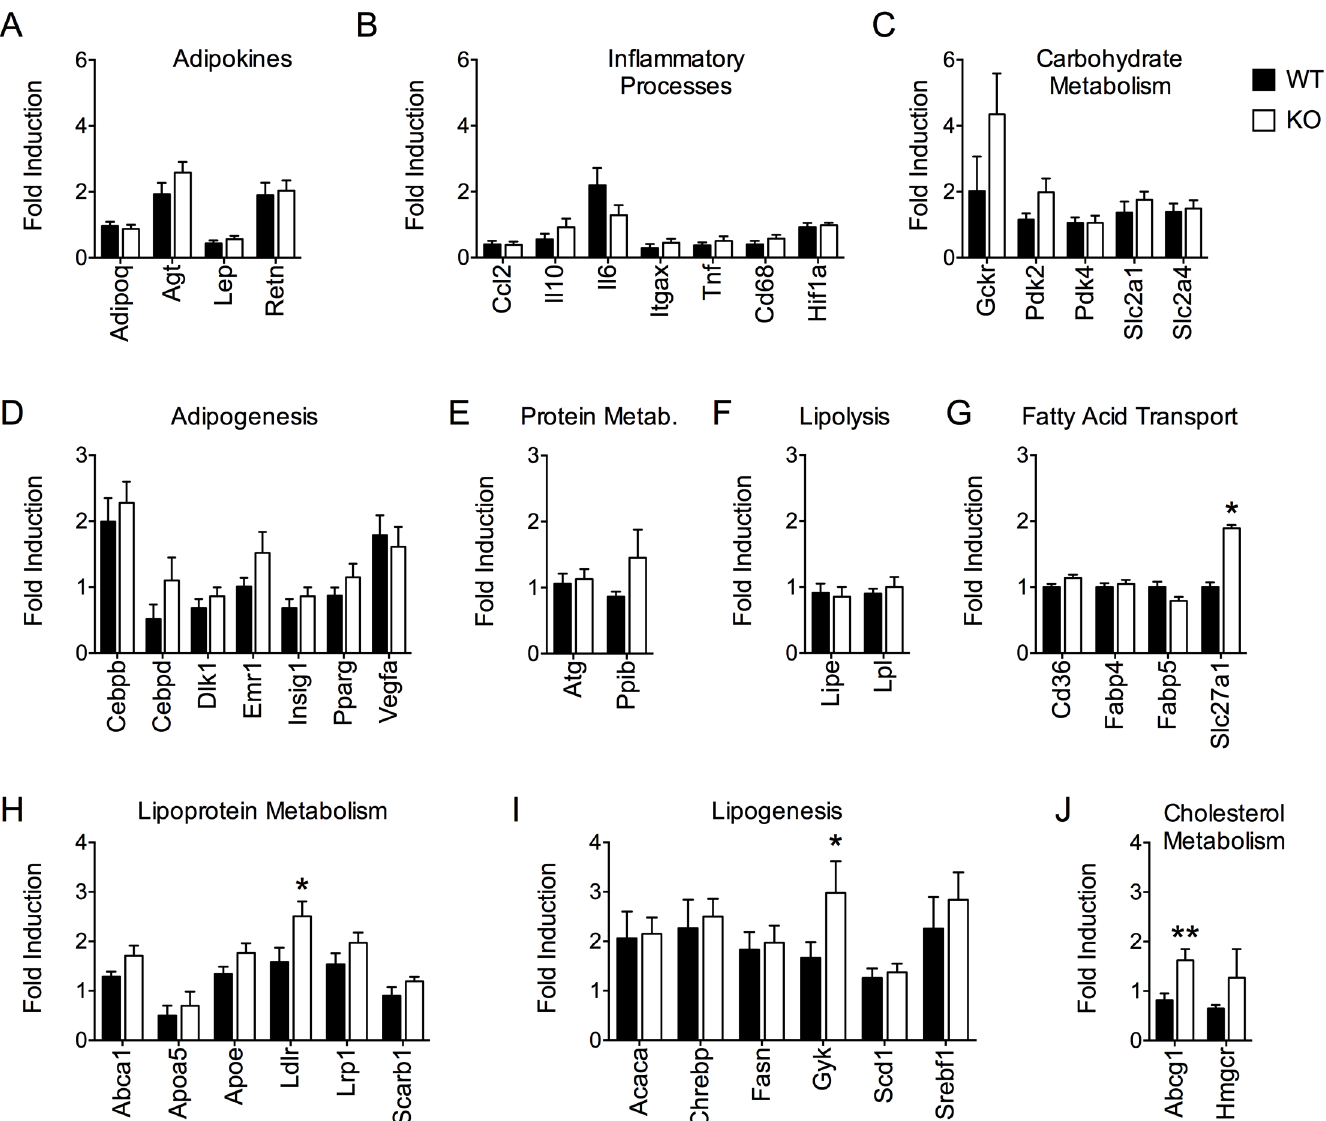
Fig 5. Gene profiling of epididymal white adipose tissue. Low-density microarrays for adipokines (A) and enzymes important for inflammatory processes (B), carbohydrate metabolism(C), adipogenesis(D), protein metabolism(E), lipolysis(F), fatty acid transport (G), lipoproteinmetabolism(H), lipogenesis(I) and cholesterolmetabolism(J) revealeda significantup-regulation of genesimportant for fatty acid transport ( Slc7a1 ),lipogenesis ( Gyk ), lipoproteinmetabolism( Ldlr ),and steroid metabolism ( Abcg1 )in eWAT of HFD-fed Dusp6 KO mice, comparedto WT controls. All results were normalized to the expressionof 18S. Means ± SEM, n = 8. * p < 0.05, ** p <